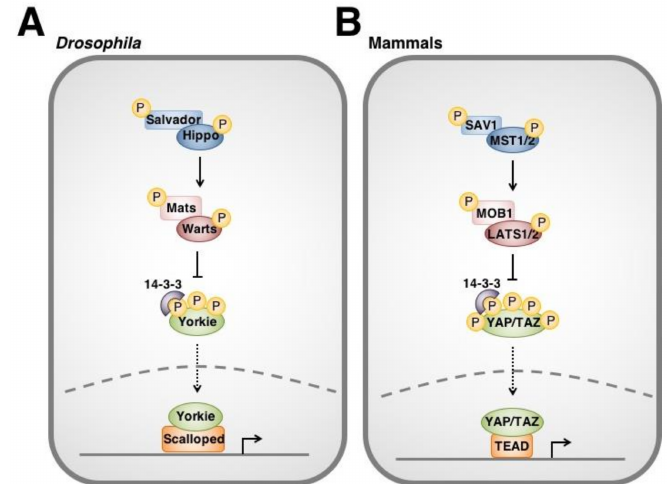
Figure 1. Overview of the Hippo signaling pathway in Drosophila ( A ) and mammals ( B ). Hippo signaling is initiated by a variety of upstream stimuli. Activation of Hippo (MST1/2) leads to subsequent phosphorylation of Warts (LATS1/2). Warts negatively regulates the Hippo pathway effector Yorkie (YAP/TAZ). Unphosphorylated Yorkie translocates into the nucleus where it interacts with its Scalloped (TEAD) transcription factors to upregulate the transcription of a variety of genes. In contrast, phosphorylation of Yorkie by Wts lead to its cytoplasmic sequestration by 14-3-3 proteins and